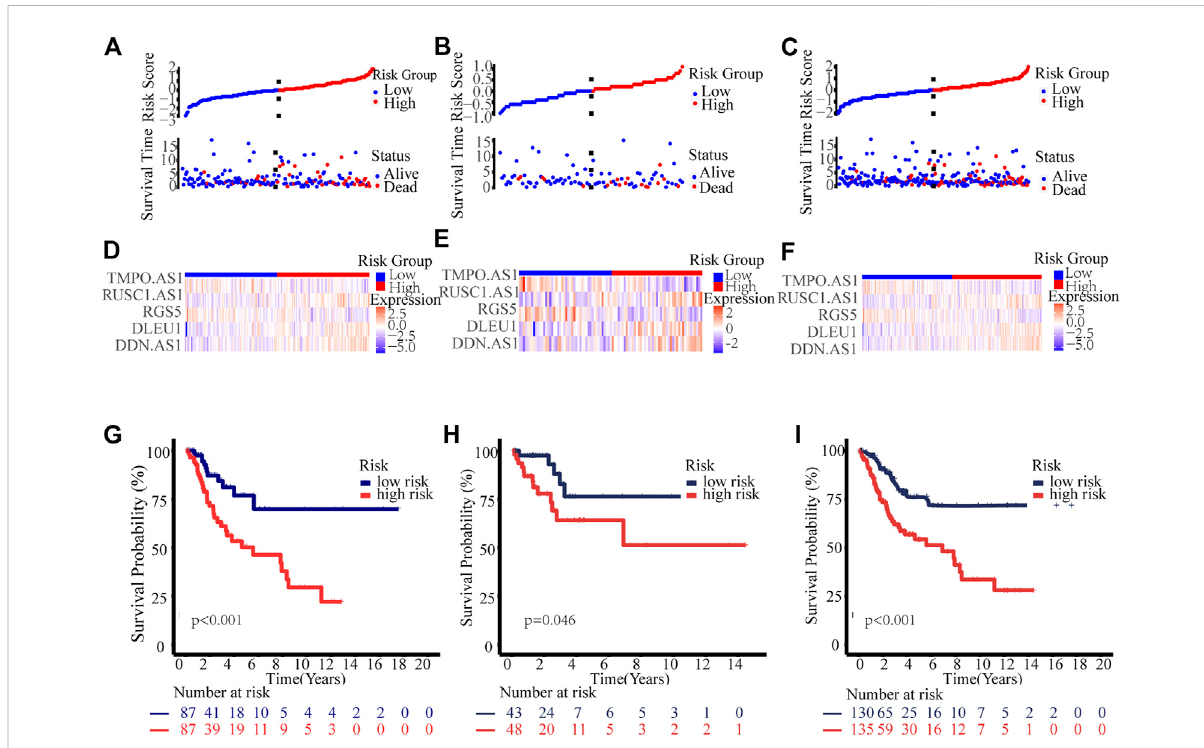
FIGURE 3 Prognosis value of the novel necroptosis-related lncRNAs prognostic model. Exhibition of the novel necroptosis-related lncRNAs signature based on risk score of the training, testing, and entire sets, respectively. Survival time and survival status between low and high-risk groups in the training (A) , testing (B) , and entire sets (C) , respectively. Heat map of fi ve lncRNAs expression in the training (D) , test (E) , and entire sets (F) , respectively. Kaplan – Meier survival curves of OS of patients between low- and high-risk groups in the training (G) , test (H) , and entire sets (I) , respectively.